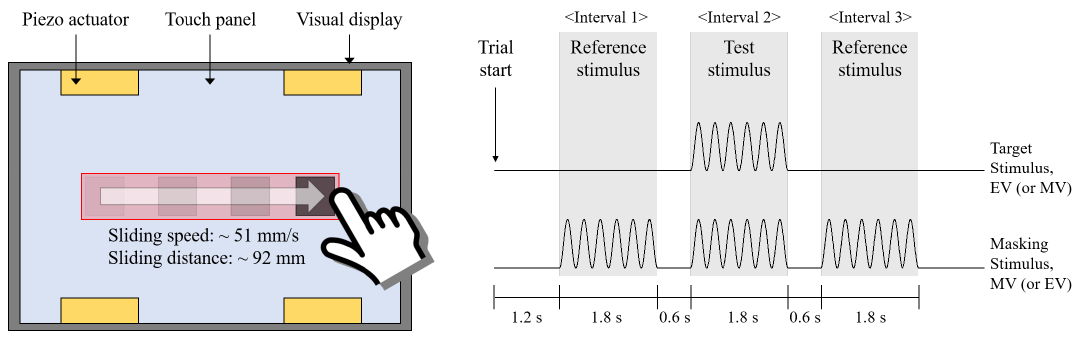
Figure 2. Experimental procedure and stimulus sequence within a three-interval, forced-choice (3IFC) paradigm. The test stimulus was randomly applied at one of the three